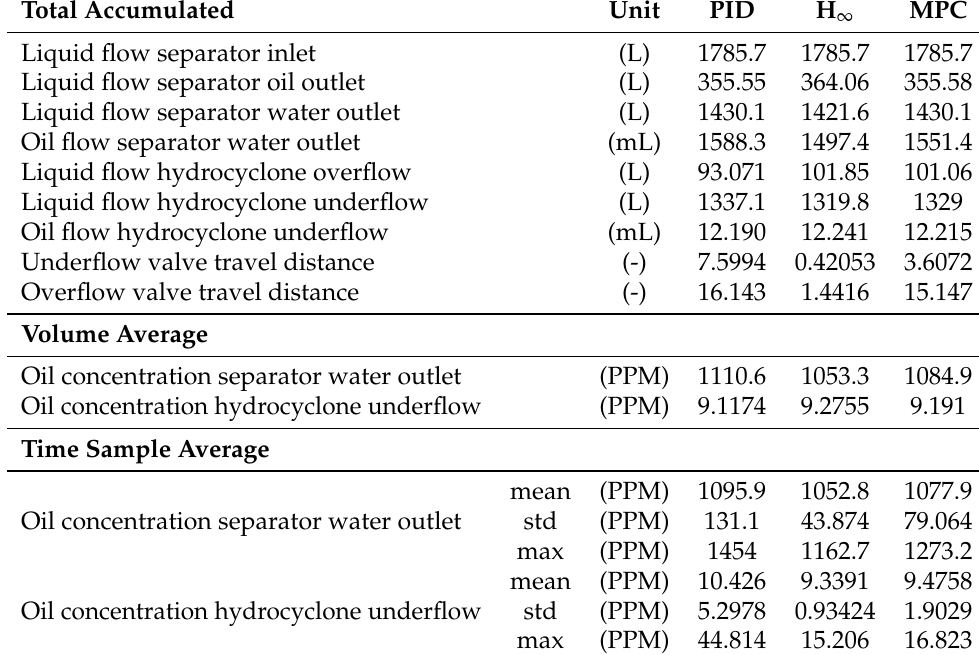
Table 1. Selected accumulated values and average concentrations of the 3500 s